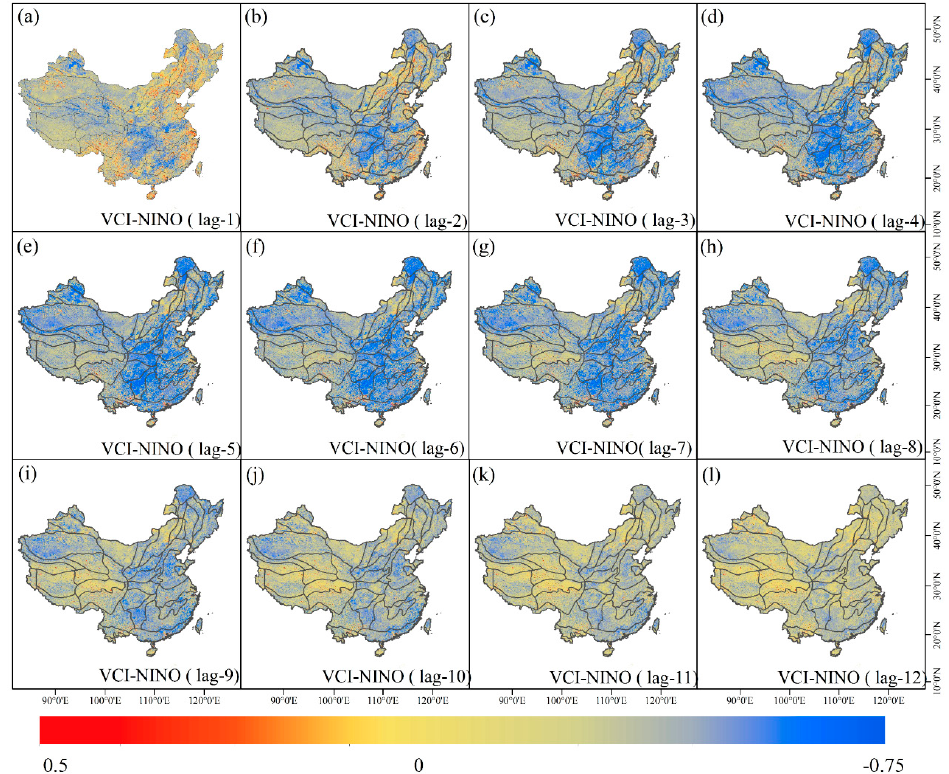
Figure 8. Distribution of correlation coefficients between the VCI and Niño 3.4 in different lag periods: ( a – l ) the spatial distribution of the correlation between Niño 3.4 and VCI when Niño 3.4 is shifted 1–12 months. Table 2. Extraction results of the mean and maximum values of the correlation coefficients be- tween the VCI and Niño 3.4 in different lag periods.